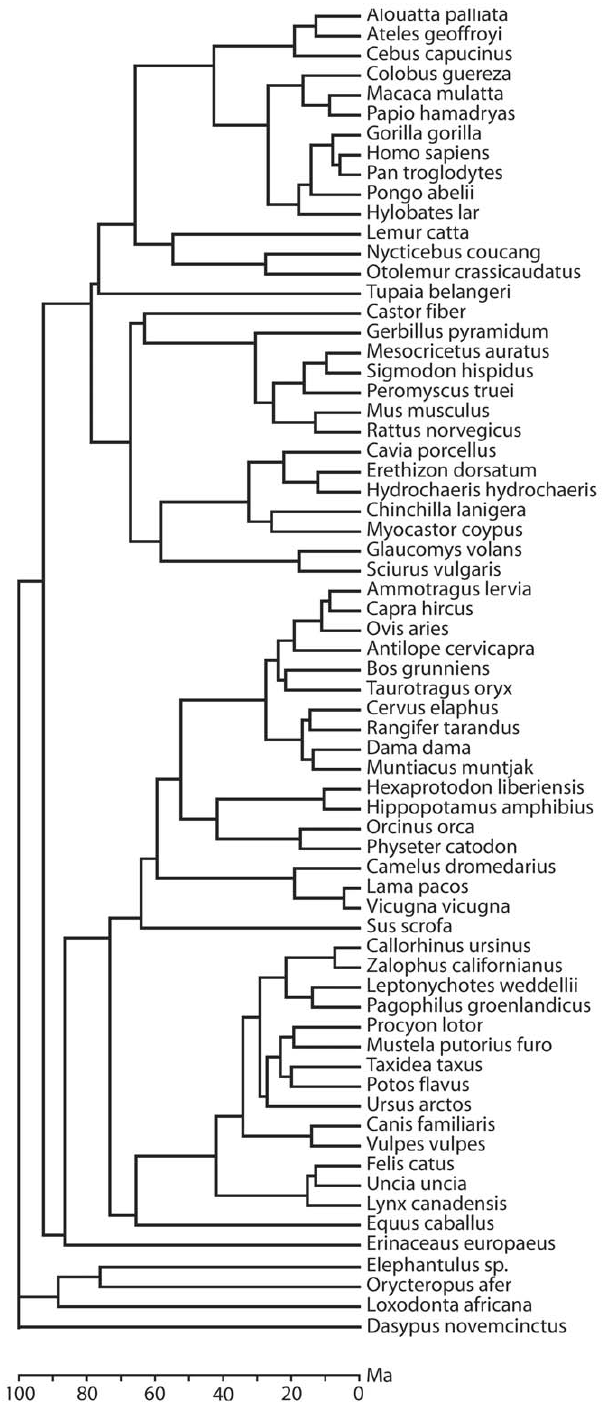
Figure 1. Phylogenetic relatedness and evolutionary diver- gence times of species in the present sample. Chronogram based on phylogenetic analysis complemented with phylogenomic data of the species in the present sample (N=67) (Tables S1, S2, S3; see also Materials and Methods). The branch points indicate when in phylogeny different species diverged from each other and a time scale in Ma (Million years ago) is shown at the bottom.